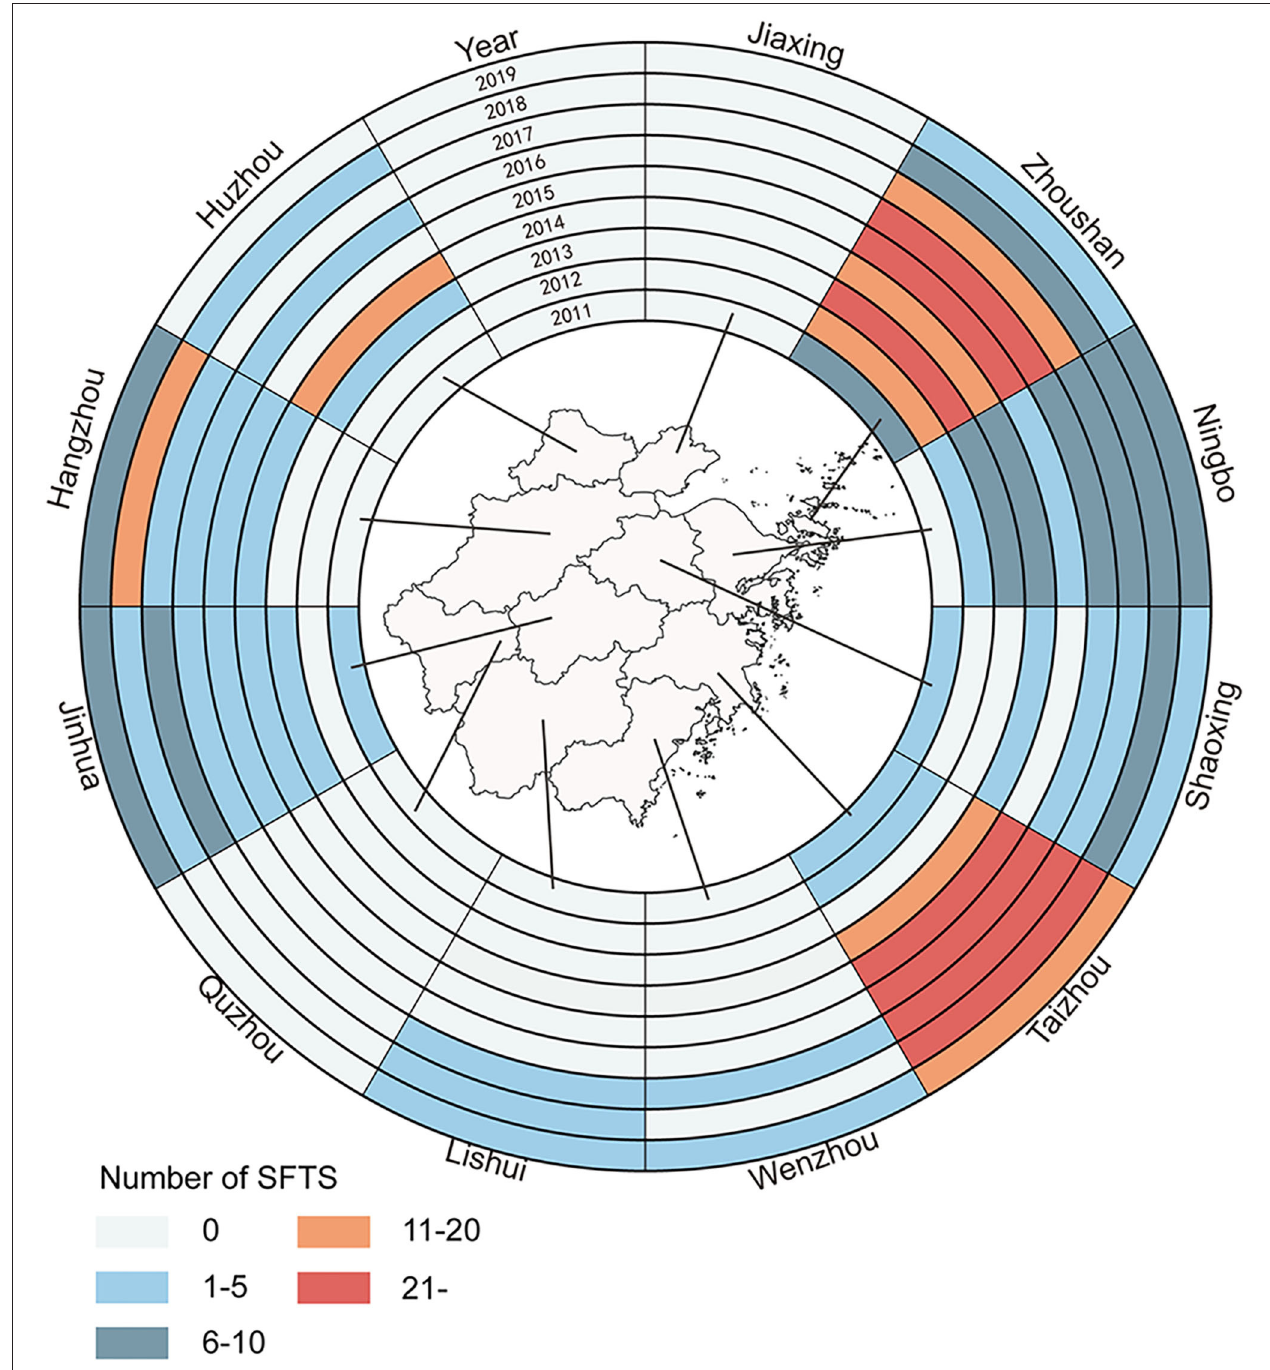
FIGURE 5 | Spatio-temporal distribution of SFTS cases in Zhejiang Province from 2011 to